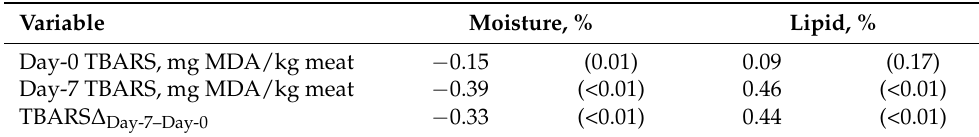
Table 5. Pearson correlation coefficients (r) for composition (moisture and lipid) with rate of lipid oxidation during a simulated retail